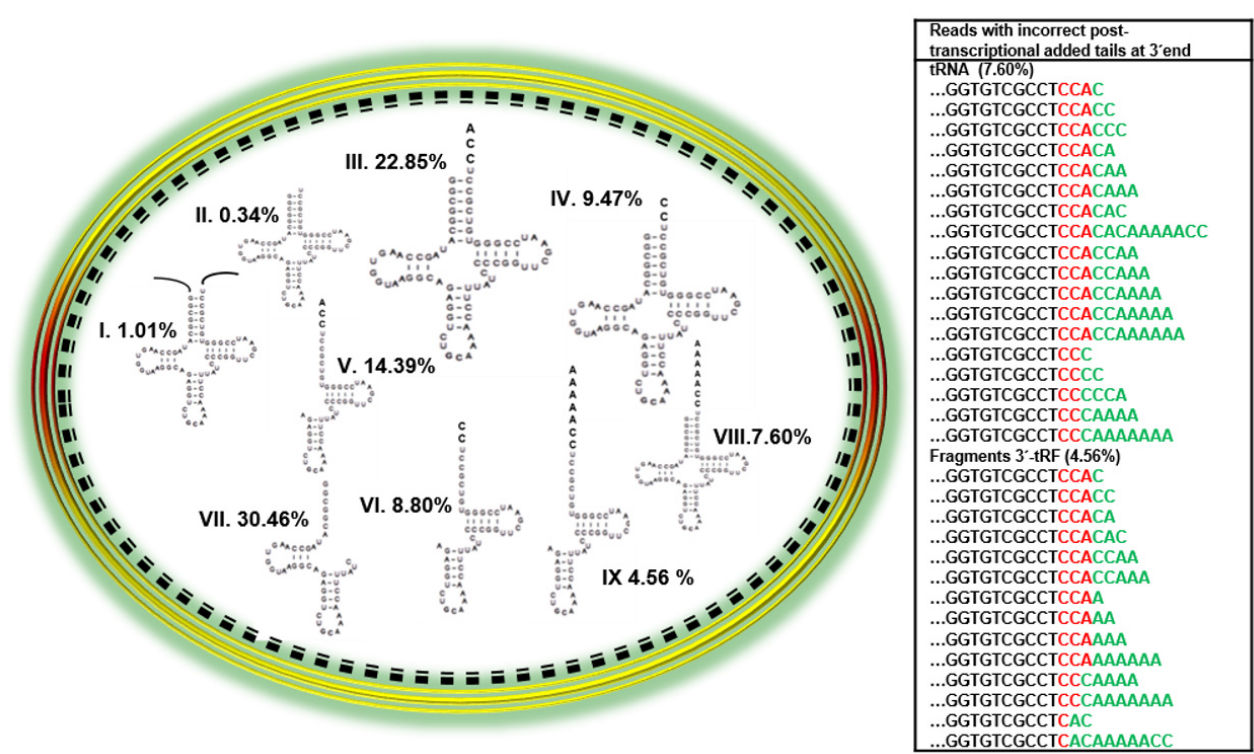
Figure 1. Overview of subpopulations of tRNA Cys -related molecules in B. subtilis dormant spores. Reads categorized were: I) precursors, II) immature tRNA, III) mature tRNA with 3’ CCA ends, IV) immature tRNA with 3’ CC ends, V) 3’-tRF fragments detected with 3’ CCA ends, VI) 3’-tRF fragments detected with 3’ CC ends, VII) 5’-tRF or internal fragments, VIII) complete tRNA with incorrect 3´ tails added and IX) 3´-tRF fragments with incorrect 3´ tails added. The numbers after each category indicate the percentage of total tRNA Cys represented by that species. The table at the right shows the tails associated with the various tRNA Cys species in